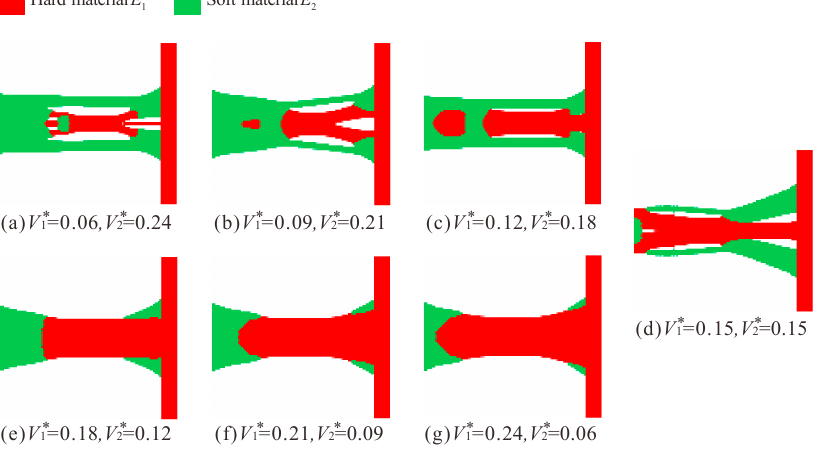
Figure 10. Topology optimization results of multi-material flexure hinge for different volume fraction combinations ( E 1 = 71 GPa, E 2 = 40 GPa).